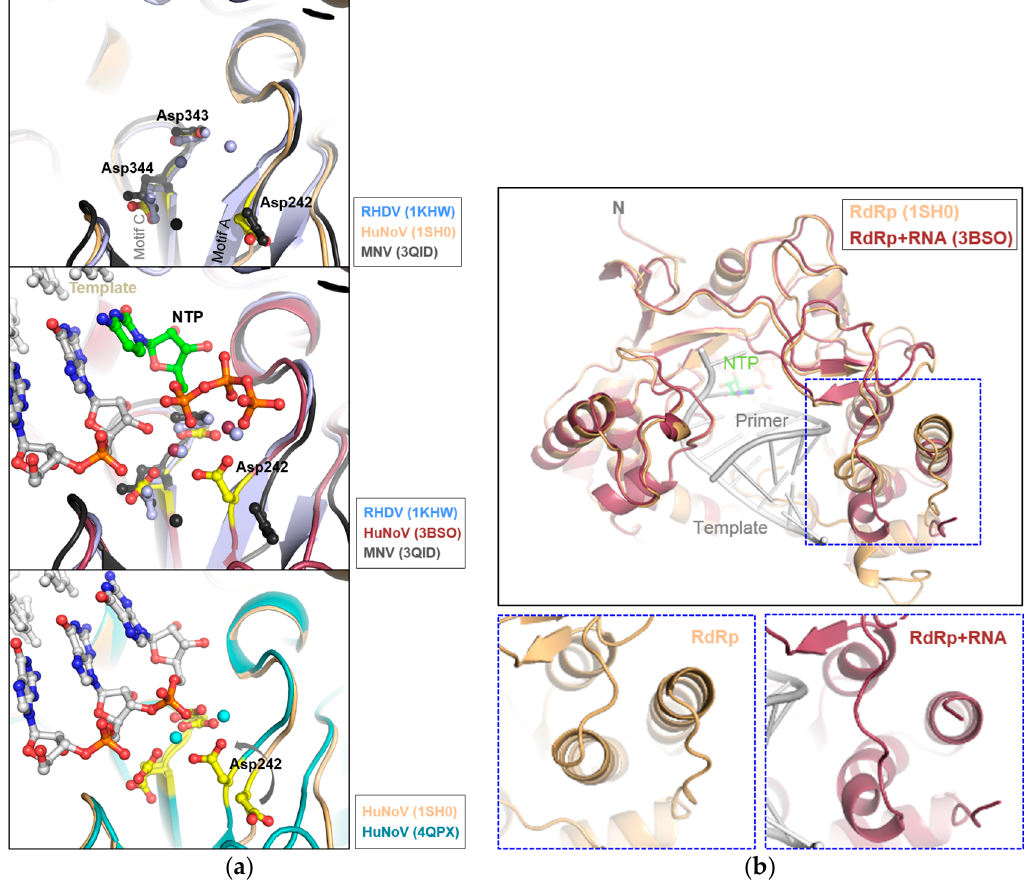
Figure 3. Details of the superimposed active sites of RdRps. ( a ) Structures of the apoenzyme with catalytic Asp in the motifs A and C and divalent metal ions (Mn 2+ ) (upper panel), the RNA/NTP-incorporated (middle), showing incoming NTP (CTP), and the backtracked state (lower panel), showing elongated RNA after incorporation of NTP with Mn 2+ in the HuNoV RdRp. The RdRp structures of RHDV (1KHW), HuNoV (1SH0, 3BSO and 4QPX), and MNV (3QID) were used for superposition; ( b ) The top view of superimposed HuNoV RdRp structures shows flexible thumb movement during RNA synthesis in a dotted box, with template, primer, and NTP. The apo and RNA-bound structures are shown below.